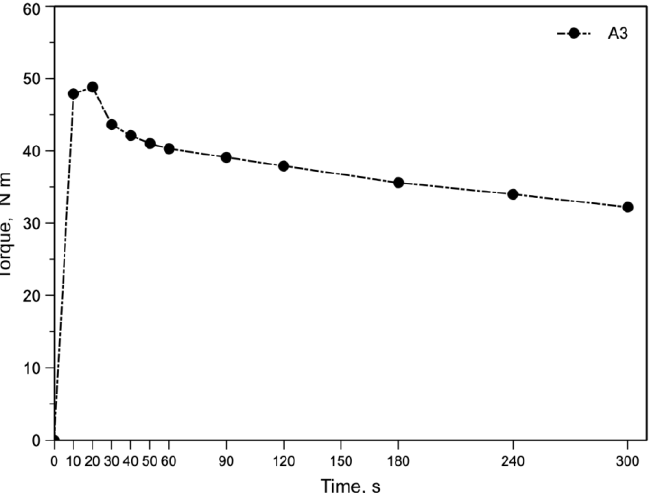
Figure 7. Curve of the torque as a function of mixing time for A3 sample.